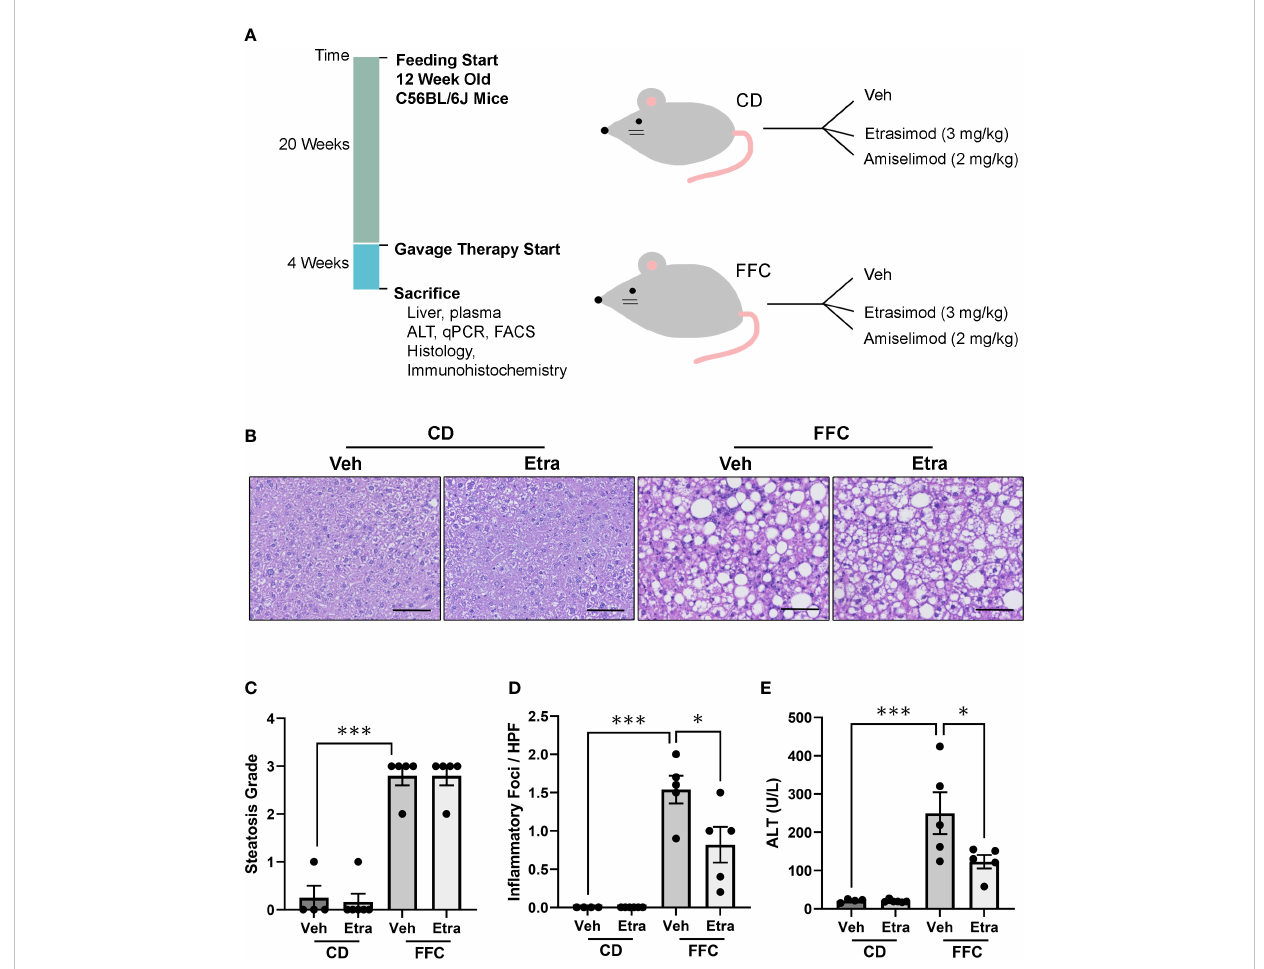
FIGURE 1 Etrasimod treatment reduces liver injury. (A) Timeline of mouse study and analysis after euthanasia. Dietary feeding started 6 weeks after acquisition of C57BL/6J male mice at 12 weeks of age. Mice were randomized to receive standard CD or FFC diet for 24 weeks. At 20 weeks of feeding, CD and FFC cohorts received vehicle or Etrasimod and vehicle or Amiselimod drug treatment for 4 weeks. Mice were euthanized at the end of gavage therapy and processed for analysis. (B) Representative liver histology shown by Hematoxylin and Eosin (H&E) staining of vehicle or Etrasimod